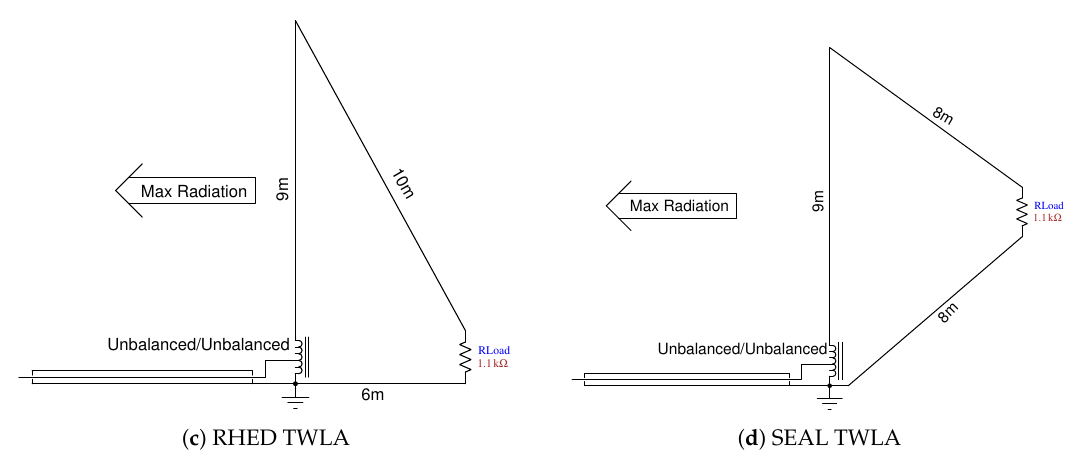
Figure 1. Antenna Designs (Not to Scale). Approximation to the SeaSonde long range transmitting antenna ( a ). Layout of the directive loop travelling wave antennas: The electrically small Vertical Half Rhombic (VHR) ( b ) used as initial prototype design; ( c , d ), layout of the current deployments at Red Head and Seal Rocks, New South Wales. Lengths of the three arms of the loop are given (in m) in the antenna layout, along with the values of the termination or loading resistor (in k Ω